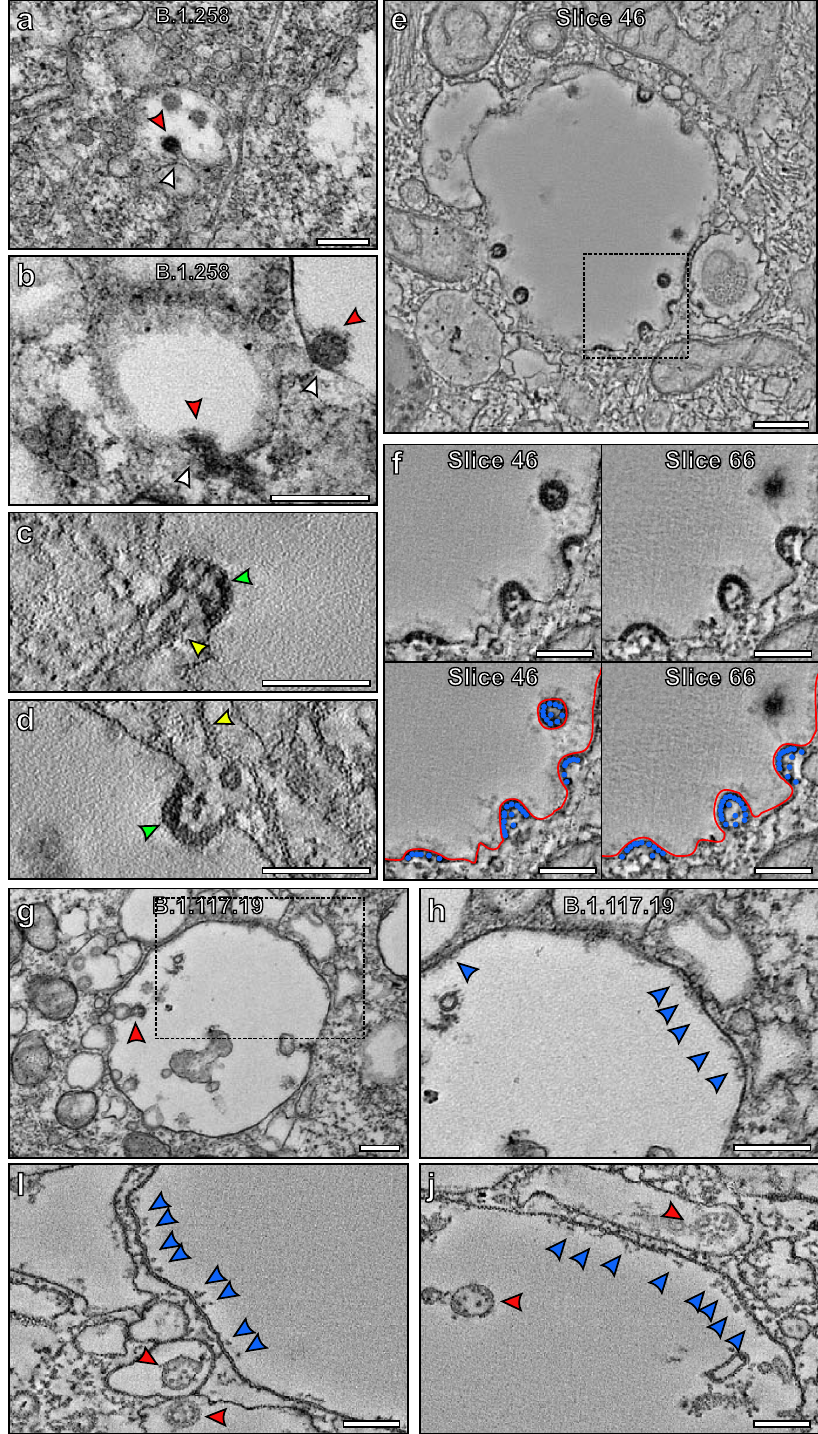
Fig. 7 Virions appear to bud into VCs coated in S glycoprotein that are transferred from the limiting membrane. a , b Virions (red arrowheads) appear to be budding into a VC which has a S glycoprotein coat. c – f Slices from tomograms indicating budding at the limiting membrane of a VC. Microtubules were seen running into budding virions ( c ) or nearby ( d ) as indicated by the yellow arrowheads. The boxed region in ( e ) is shown at higher magni fi cation in ( f ) that includes two different slices from a tomogram. The nucleocapsid protein appeared to be concentrated at the membrane of the budding virions (false coloured blue in ( f ) and green arrowhead in ( c , d )). The boxed region in ( g ) is shown at higher magni fi cation ( h ) of a VC that contains a virus (red arrowhead) and has S glycoprotein (blue arrowheads) on the limiting membrane facing the lumen. i , j Slices from tomograms generated of VCs showing S glycoprotein on the limiting membrane in more detail. Viral particles were within the VCs as well as surrounded by membranes in structures close by. Scale bars ( a , b , e , g , h ) 200 nm and ( c , d , f , i , j ) 100